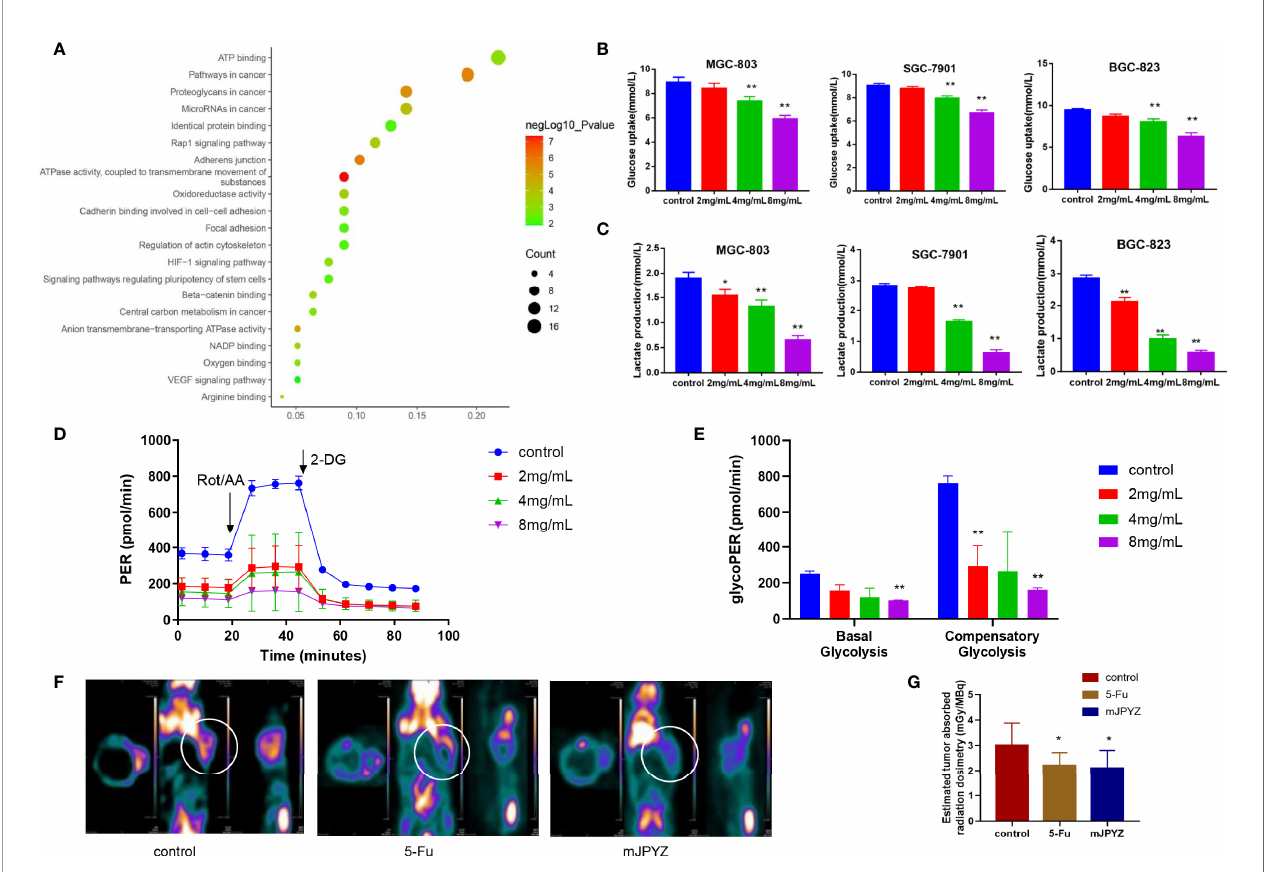
FIGURE 3 | The effects of mJPYZ on EMT of gastric cancer cells depended on aerobic glycolysis. (A) Network pharmacology and Gene Oncology (GO) analysis investigated mJPYZ corresponding pathways participate in progress of gastric cancer and found related to aerobic glycolysis. (B, C) The effect of mJPYZ on the glucose uptake and lactate production levels in gastric cancer cells. (D, E) Extracellular acidi fi cation rates (ECAR) and Proton Ef fl ux Rate (PER) were measured in SGC-7901 cells by Seahorse XFe assays. Quanti fi cation of the PER from glycolysis of mJPYZ with control group. mJPYZ administration decreased ECARs, PER, glucose consumption and lactate production in GC cells compared with control group. (F, G) MicroPET-CT on tumor-bearing nude mice. After mJPYZ treatment, 18F- fl uorodeoxyglucose ( 18 FDG) accumulation was reduced in tumor. Data are represented as mean ± SD, n=3 independent experiments. *P < 0.05, **P < 0.01 versus control group by one-way analysis of variance (ANOVA) followed by Tukey ’ s post-hoc